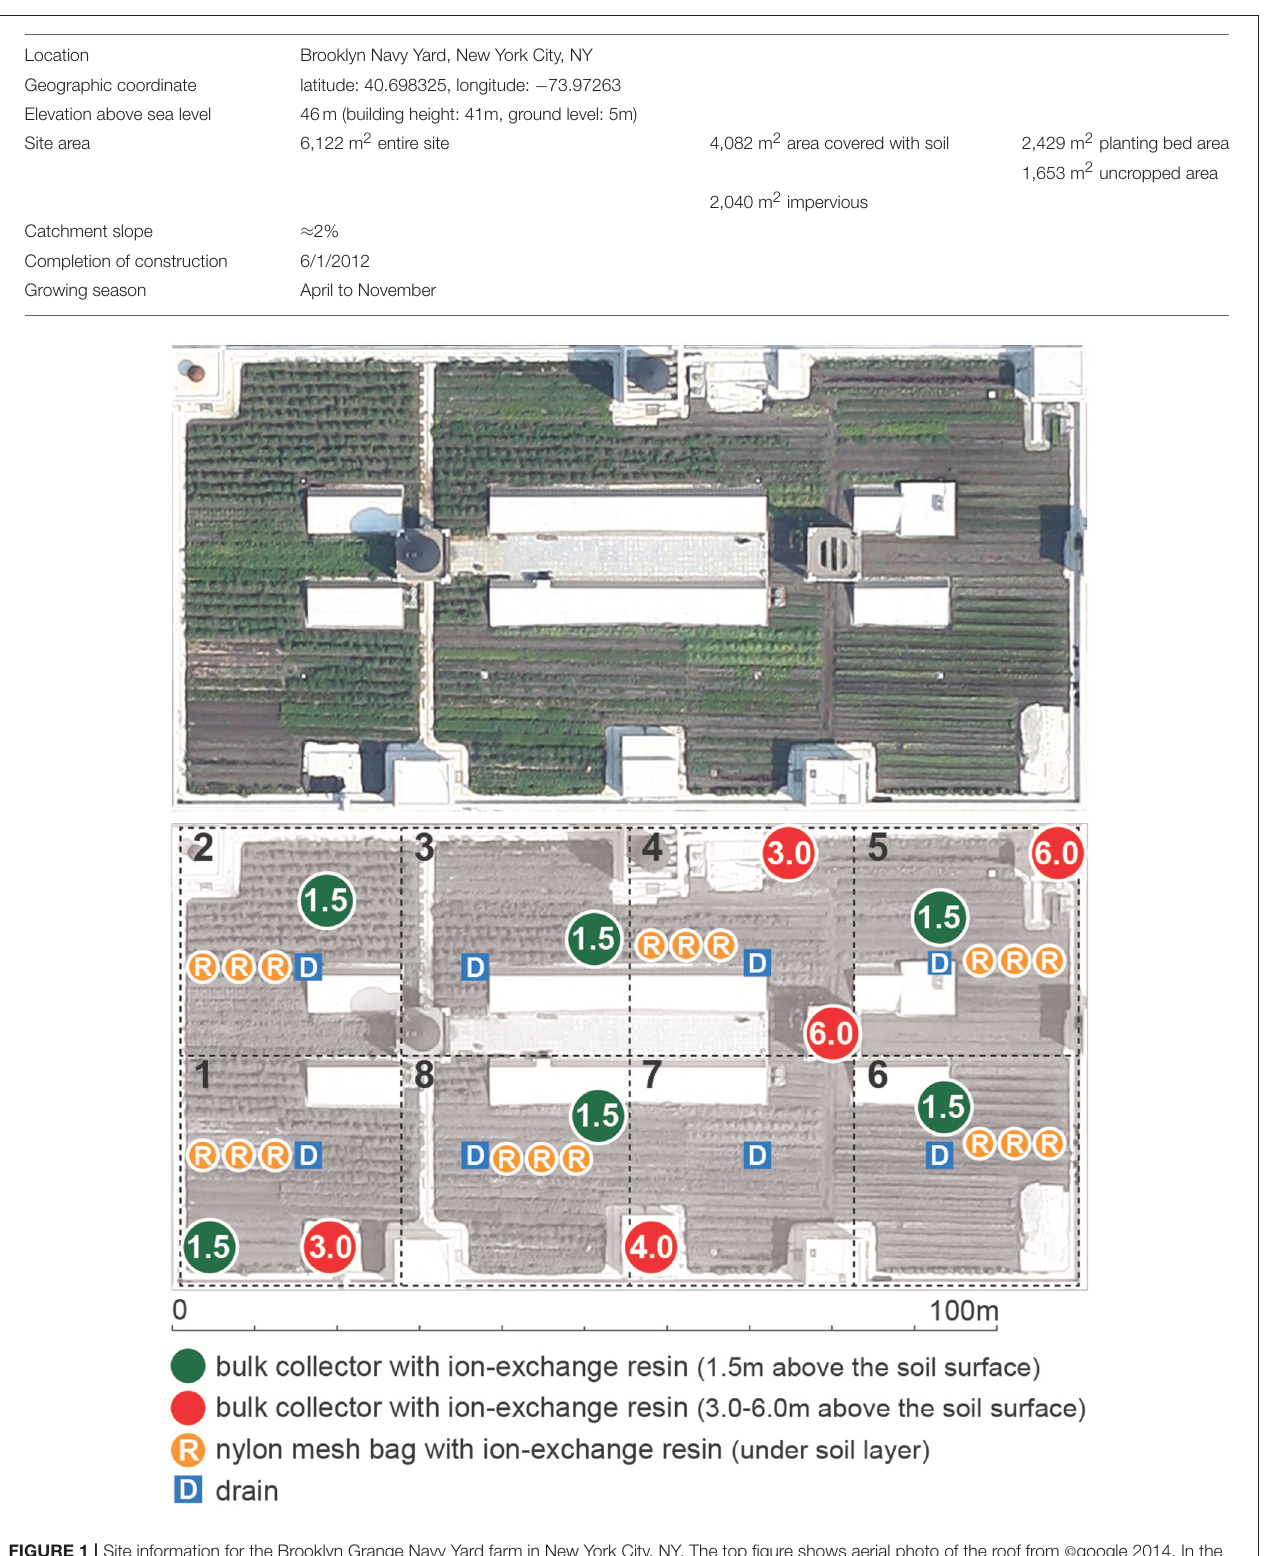
FIGURE 1 | Site information for the Brooklyn Grange Navy Yard farm in New York City, NY. The top figure shows aerial photo of the roof from © google 2014. In the bottom figure, dotted lines indicate the eight catchments on the roof, and circled numbers indicate the height in meters of atmospheric deposition collectors above the soil